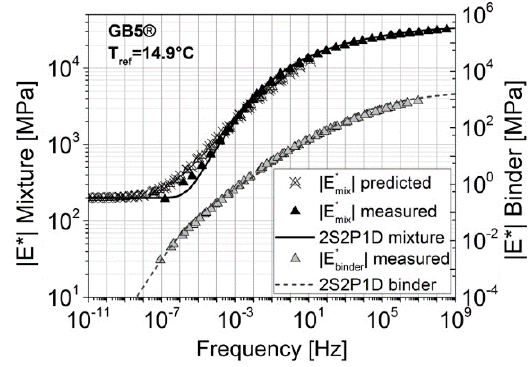
Figure 14. Geometrical transformation of the binder Cole-Cole diagram for prediction of the mixture modulus.